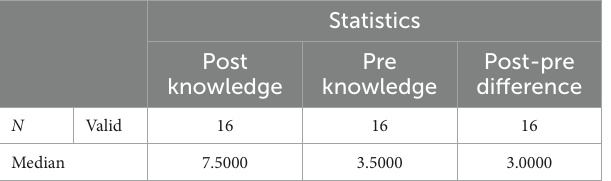
TABLE 3 Median values for posttest, pretest, and differences in post- pretest knowledge scores for scaffolded